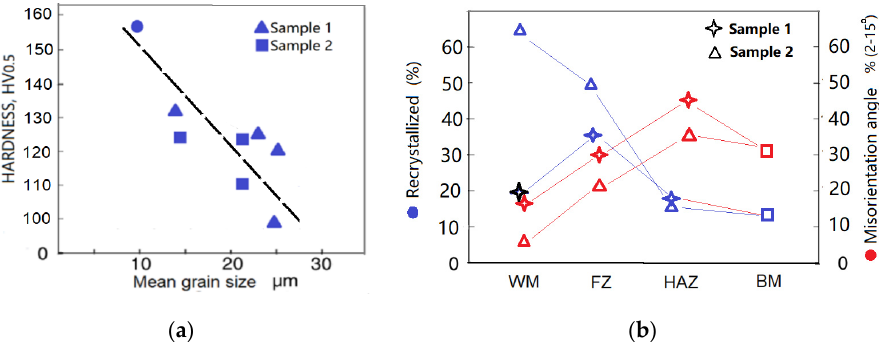
Figure 8. ( a ) Trend in H–P relationship and ( b ) distributions of recrystallized grain fraction and misorientation angle of each zone of